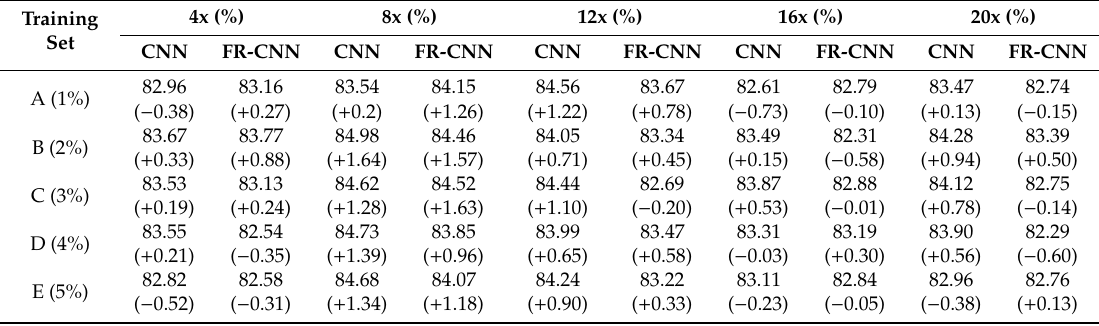
Table 6. Overall classification accuracy of di ff erent training sample sets. The value in parentheses is the increased value compared to the classification result of the original training sample